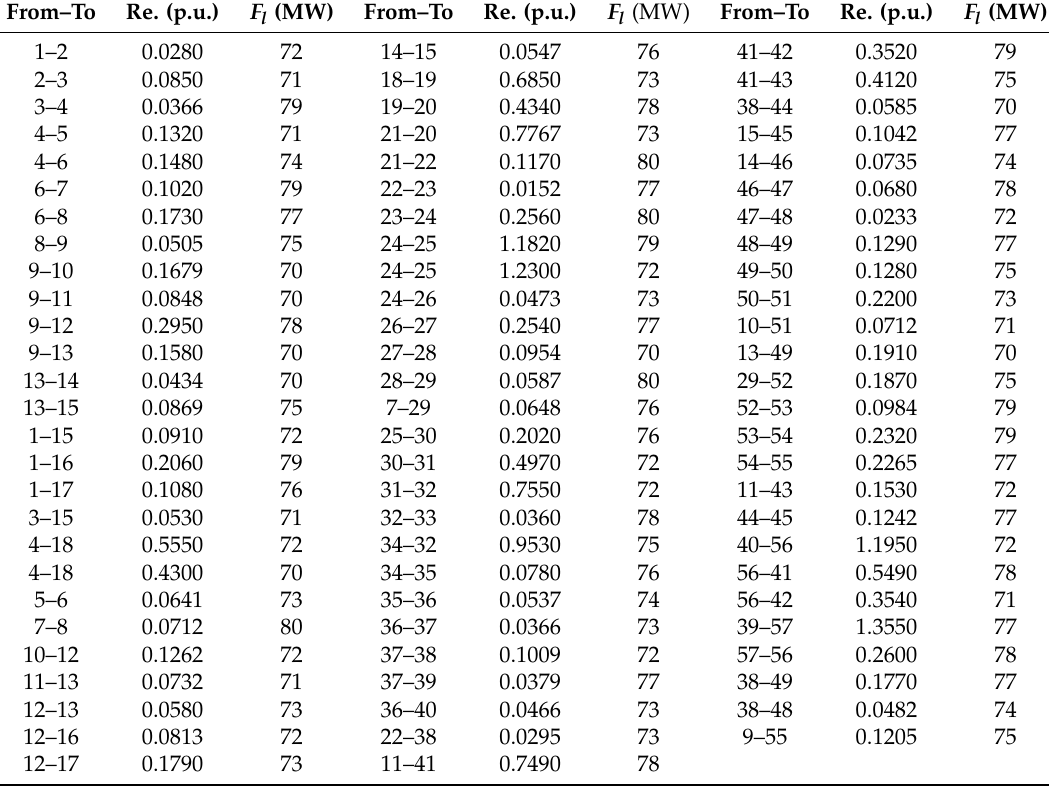
Table A2. Branch data for IEEE 57-bus